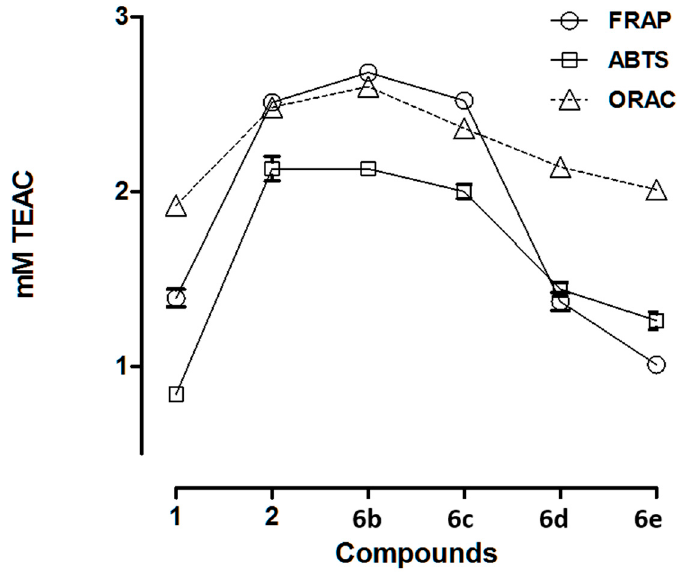
Figure 2. Antioxidant activity of from HT ( 1 ), NO 2 HT ( 2 ), and alkyl nitrohydroxytyrosyl ethers ( 6b − e ) obtained using the FRAP, ABTS, and ORAC assays.